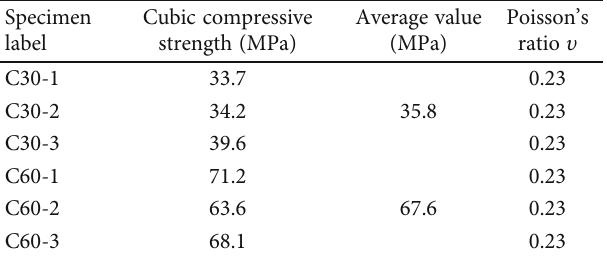
Table 2: Concrete compressive strength test results.